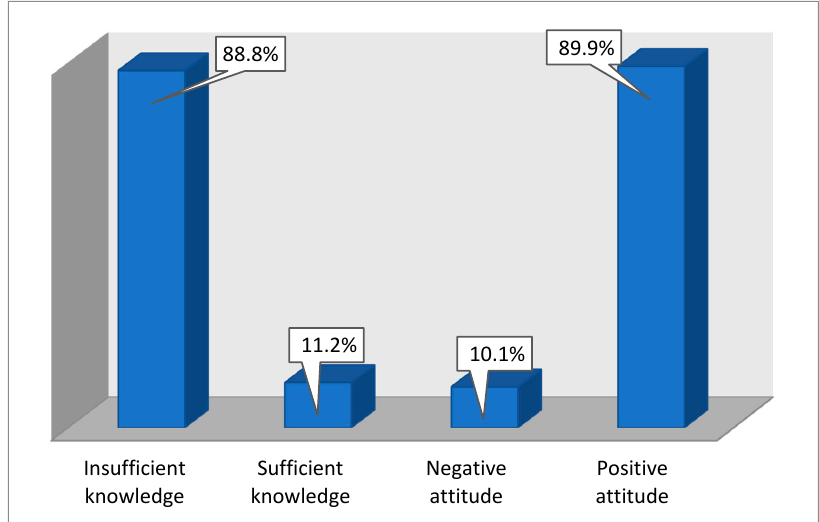
Figure 1. Frequency distribution of knowledge and attitude levels.